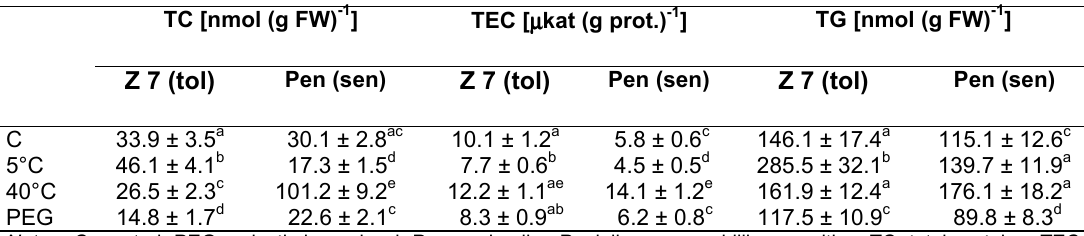
Effect of Abiotic Stresses on Total Cysteine, Total γγγγ -Glutamylcysteine, and Total Glutathione Content in Shoots of a Chilling-Tolerant Maize Line, Z 7, and a Chilling- Sensitive